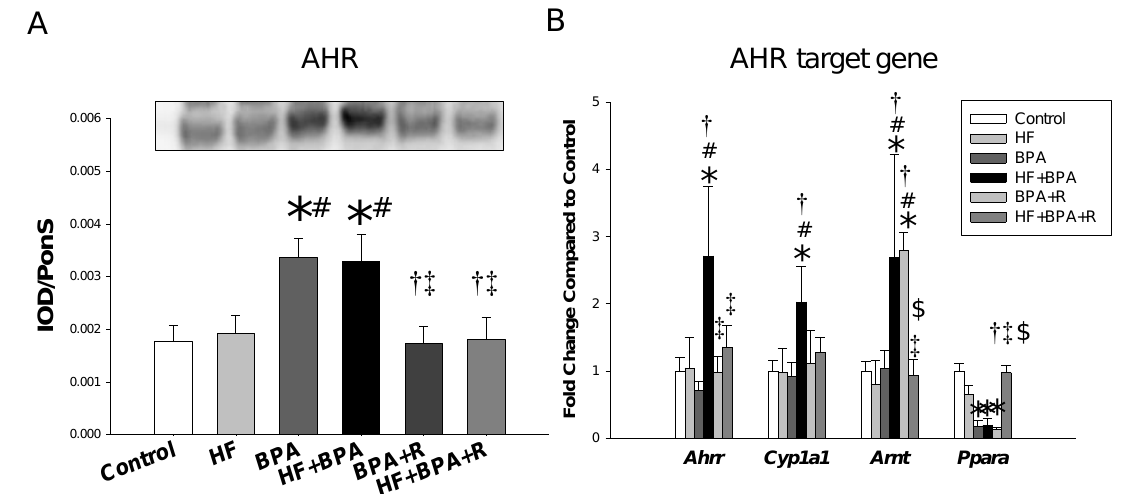
Figure 5. Effects of maternal high-fat diet (HF), bisphenol A (BPA), and resveratrol (R) on ( A ) the aryl hydrocarbon receptor (AHR) protein level and ( B ) mRNA expression of AHR target genes, including Ahrr, Cyp1a1, and Arnt in male offspring kidneys at 16 weeks of age. n = 7–8 / group; * p < 0.05 versus control; # p < 0.05 versus HF; † p < 0.05 versus BPA; ‡ p < 0.05 versus HF + BPA; $ p < 0.05 versus BPA + R.